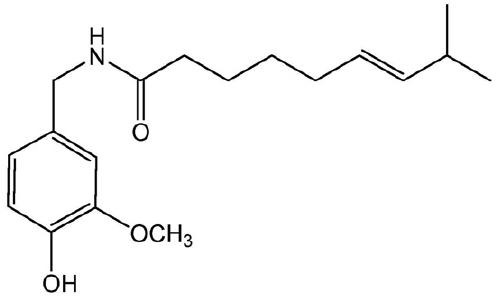
Fig. 1 . The molecular structure of Capsaicin (Al-Samydai et al ., 2019) On the other hand, alkaloid Piperine, found in Black pepper ( Piper nigrum ) which is known as the “king of spices” (Tharmalingam, 2014) from the Piperaceae family. Finally, Curcumin is the principal constituent of turmeric which extracted from Curcuma longa rhizomes (family ;